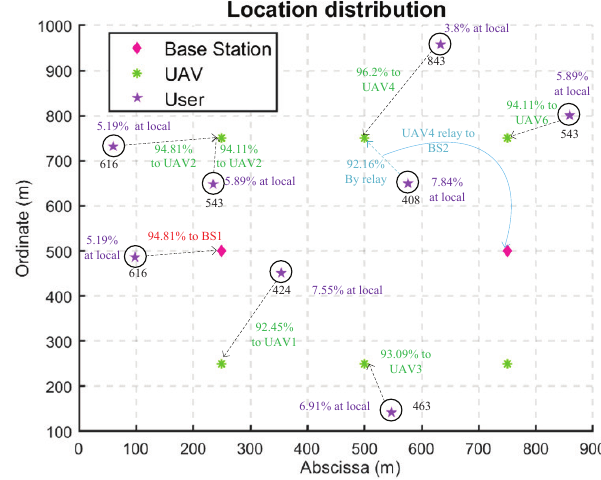
Figure 4. Optimal computation offload strategy.